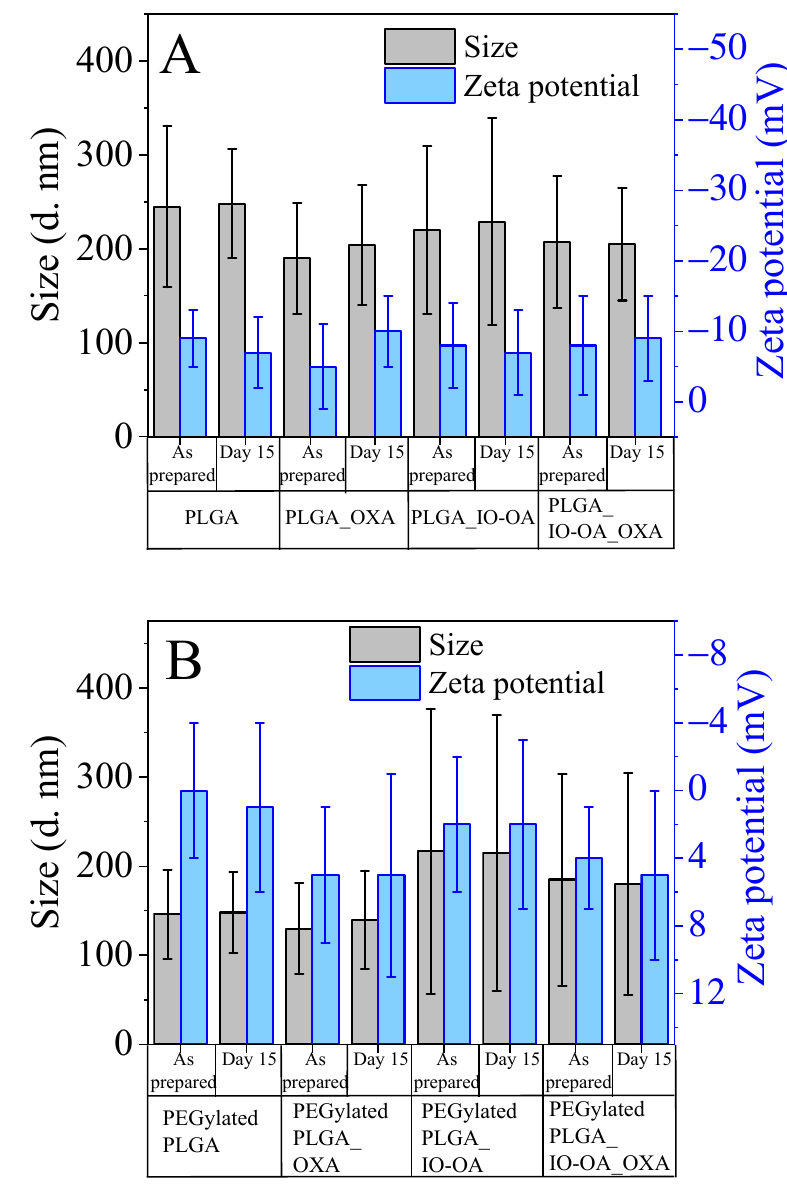
Figure 4. Size and zeta potential measurement at day one and day 15 of ( A ) PLGA nanoparticles (PLGA), oxaliplatin-loaded PLGA nanoparticles (PLGA_OXA), oleic acid-coated iron oxide-loaded PLGA nanoparticles (PLGA_IO-OA), PLGA-based multicomponent delivery systems (PLGA_IO- OA_OXA) and their PEGylated analogs ( B ). The ratio of IO-OA:PLGA, OXA:PLGA, and their PEGylated analogs is equal to 1:10.